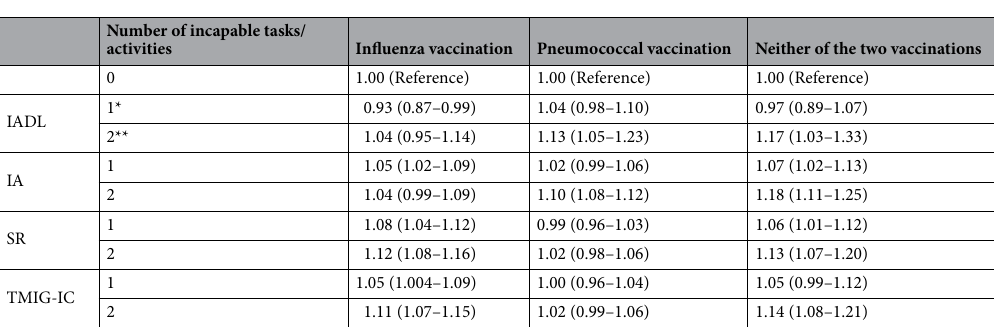
Table 2. IRRs and 95% CIs of associations between non-receipt of vaccinations and IADL, IA, SR, or TMIG-IC. IRR incident rate ratio, 95% CI 95% confidence interval, IADL instrumental activity of daily were adjusted for age, sex, marital status, educational attainment, equivalized income, household structure, smoking status, self-rated health, medical checkup, family physician, patient’s questioning attitude, high-risk disease, pneumonia, or influenza vaccination (only for non-receipt of influenza or pneumococcal vaccination), history of influenza or pneumonia, geriatric depression, homeboundness, civic participation, social cohesion, and